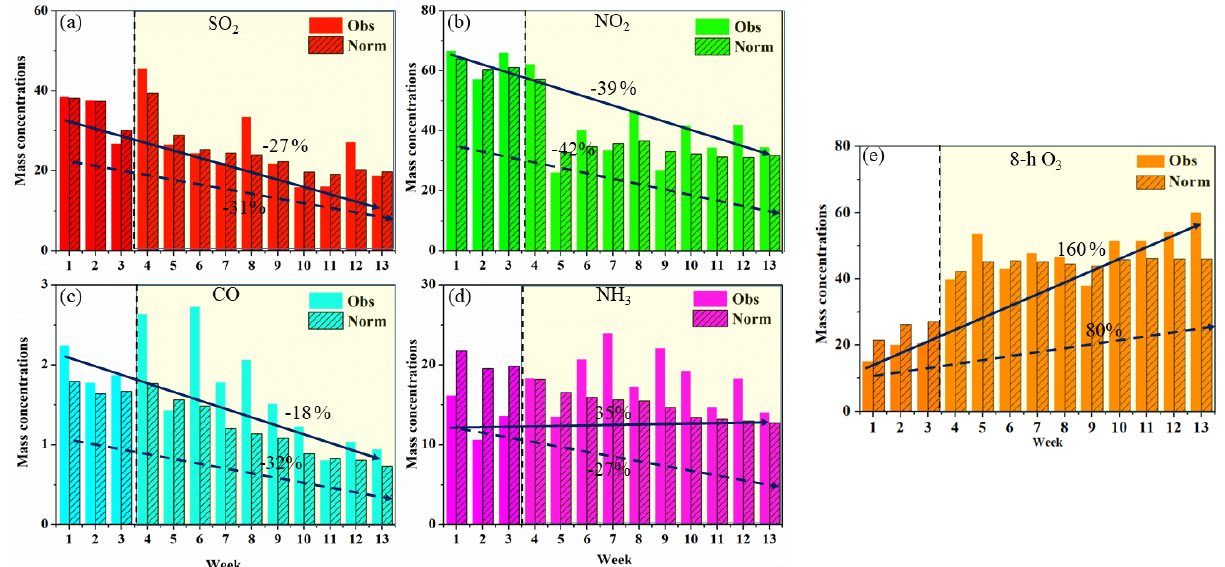
Figure 2. Observed and deweathered weekly concentrations and changes in gaseous pollutants during 1 January–31 March. The solid black line and dotted line represent the decrease ratio of observed concentration and simulated concentration from pre-COVID to post-COVID, respectively. The white background denotes the changes in gaseous pollutants before COVID-19, while the faint yellow one represents the chemical components after the COVID-19